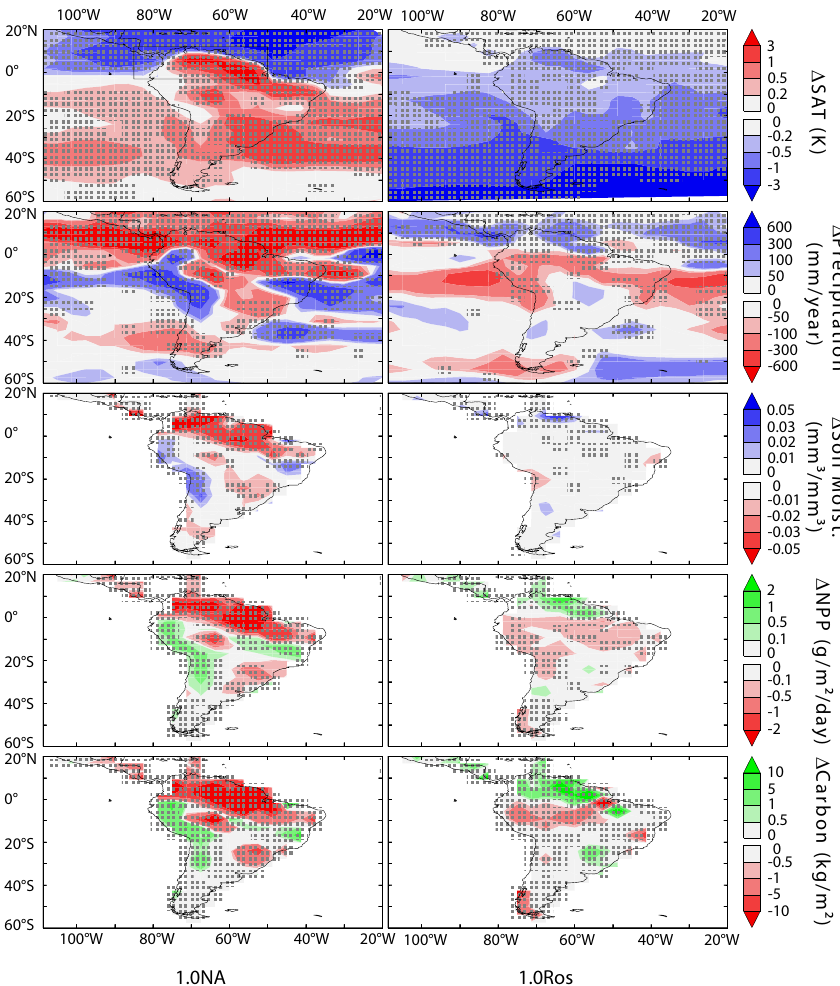
Fig. 8. Snapshots of the anomalies of various climatic variables and terrestrial carbon by the end of the perturbation (decadal average) for the experiments 1.0NA (left column) and 1.0Ros (right column). Anomalies are calculated as the 97–106 years of experiments minus the 100-year averaged Control. The variables shown from top to bottom are as follows, SAT ( ◦ C), precipitation (mmyear − 1 ), soil moisture (mm 3 mm − 3 ), NPP (gm − 2 day − 1 ) and Total Carbon (kgm − 2 ). Stippled areas indicate where the ensemble mean anomaly is significantly different from zero at the 67% level (Student’s